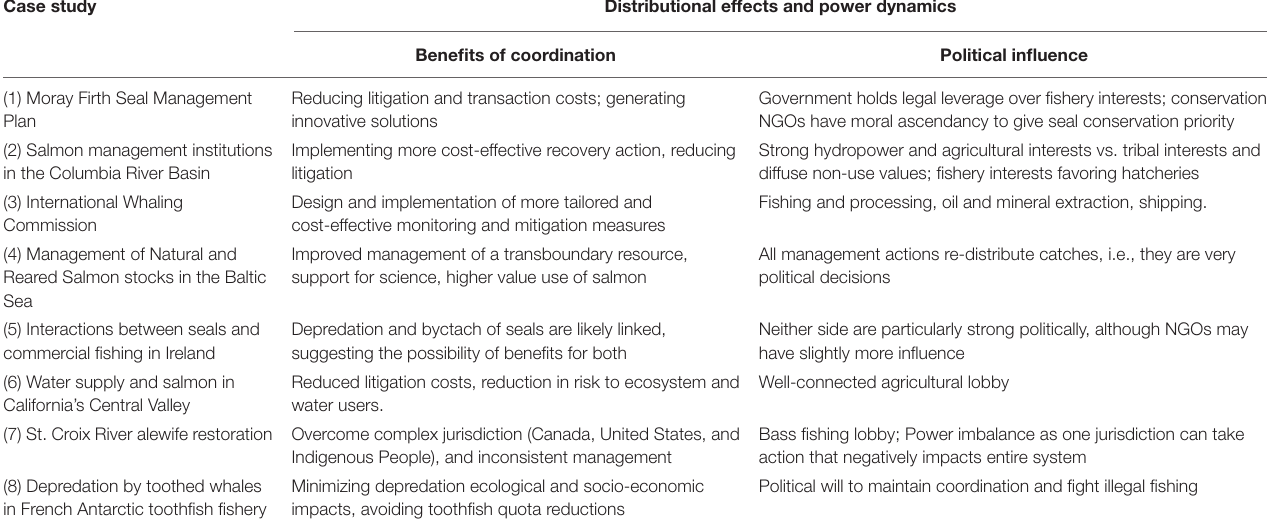
TABLE 4 | Case studies – Distributional effects and power